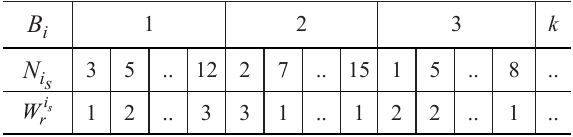
table 1. Representation (coding) of repair